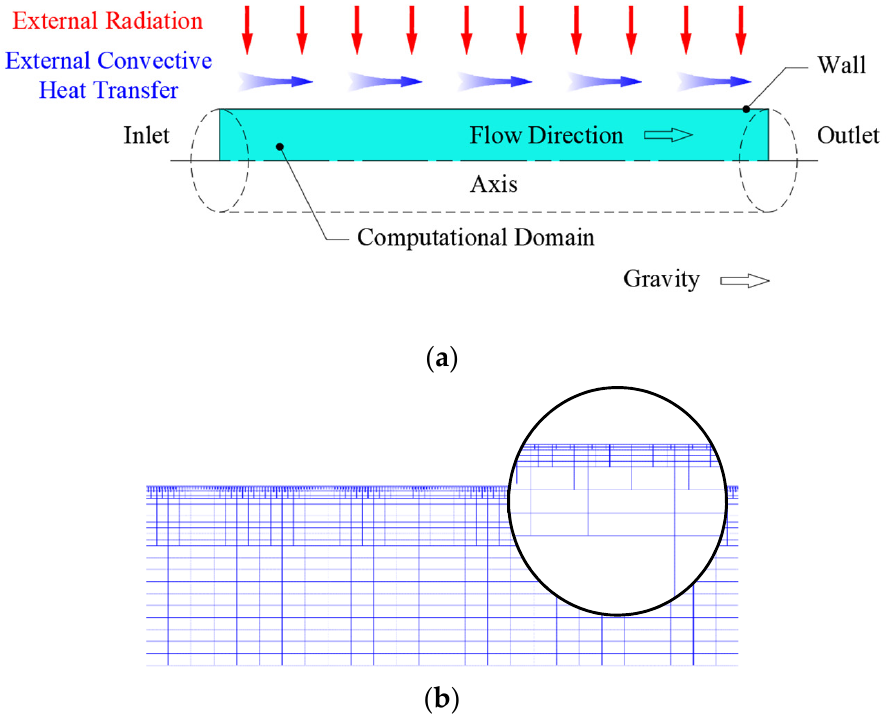
Figure 2. ( a ) Schematic of computational domain and ( b ) local mesh structure